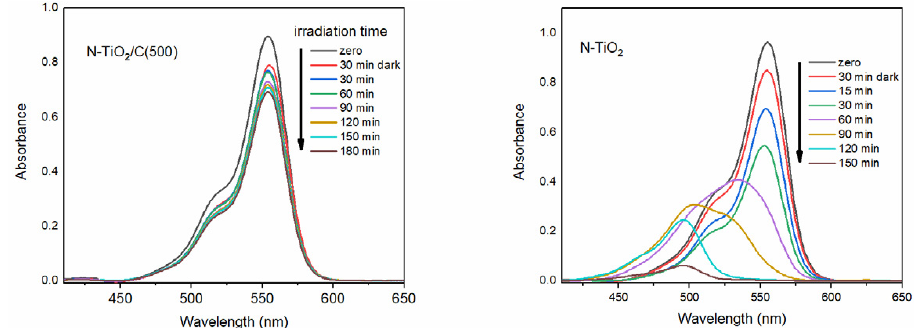
, (B) and N -TiO 2 2